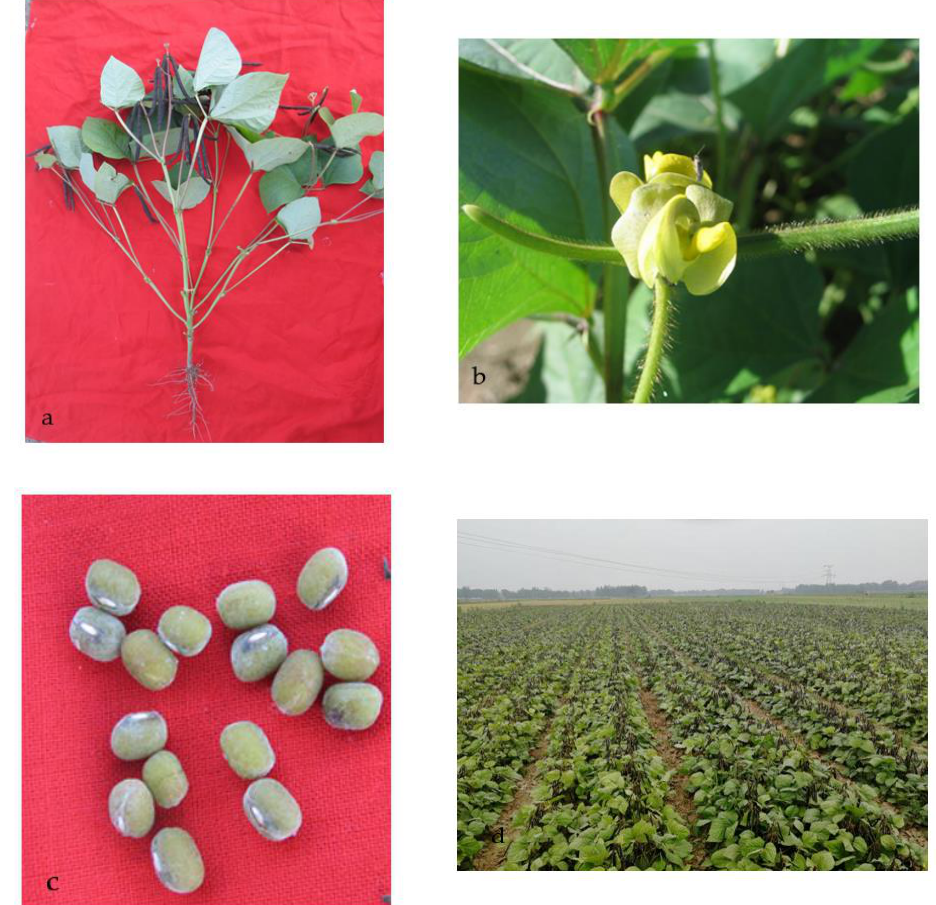
Figure 2. Characteristics of Jilv 20. ( a – d ) Typical plant ( a ), flowers and young pods ( b ), seeds ( c ), and field performance ( d ).